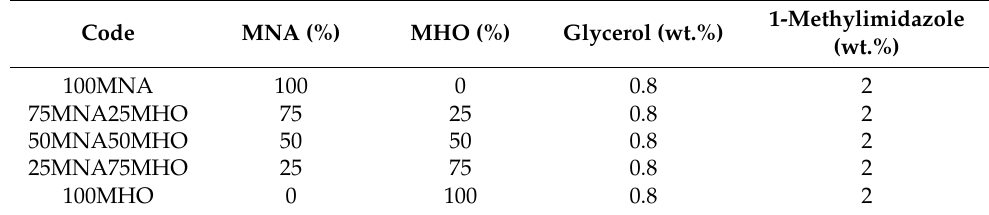
Table 2. Composition of different samples.